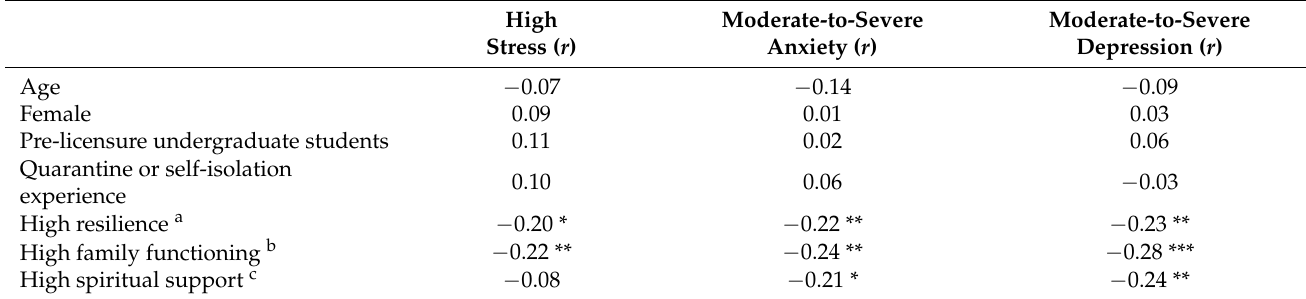
Table 1. Correlations with poor mental health during COVID-19 lockdown ( N = 173).